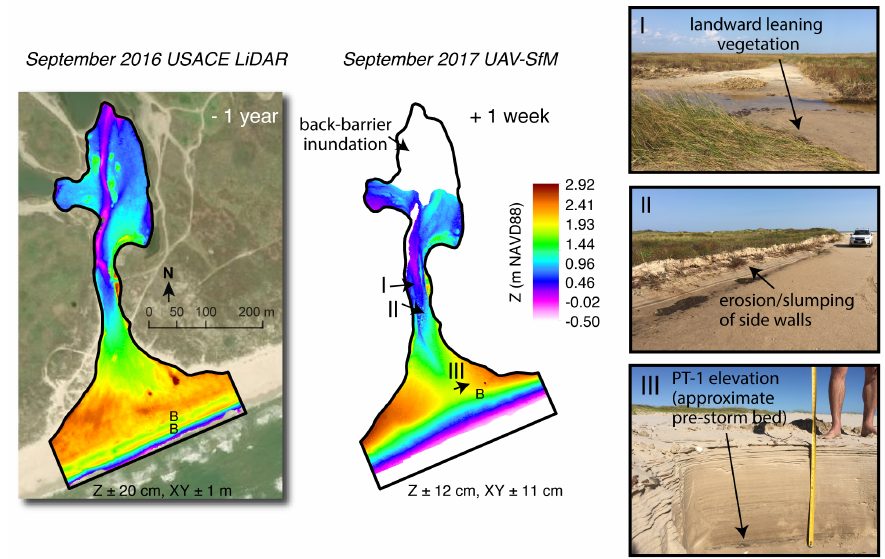
Figure 3. Morphological impacts at Matagorda Peninsula from Hurricane Harvey as shown through comparison of pre- and post-storm digital elevation maps (DEMs) as well as site reconnaissance photographs (I–III, taken one week after storm landfall). The pre-storm DEM was created from September 2016 LiDAR ( − 1 year) collected as part of the United States Army Corps of Engineers (USACE) National Coastal Mapping Program [37], and the post-storm DEM (+1 week) using images collected by an unmanned aerial vehicle (UAV) in combination with a stereo photogrammetric structure-from-motion (SfM) algorithm. The location of the berm(s) is annotated in both DEMs for interpretation of storm